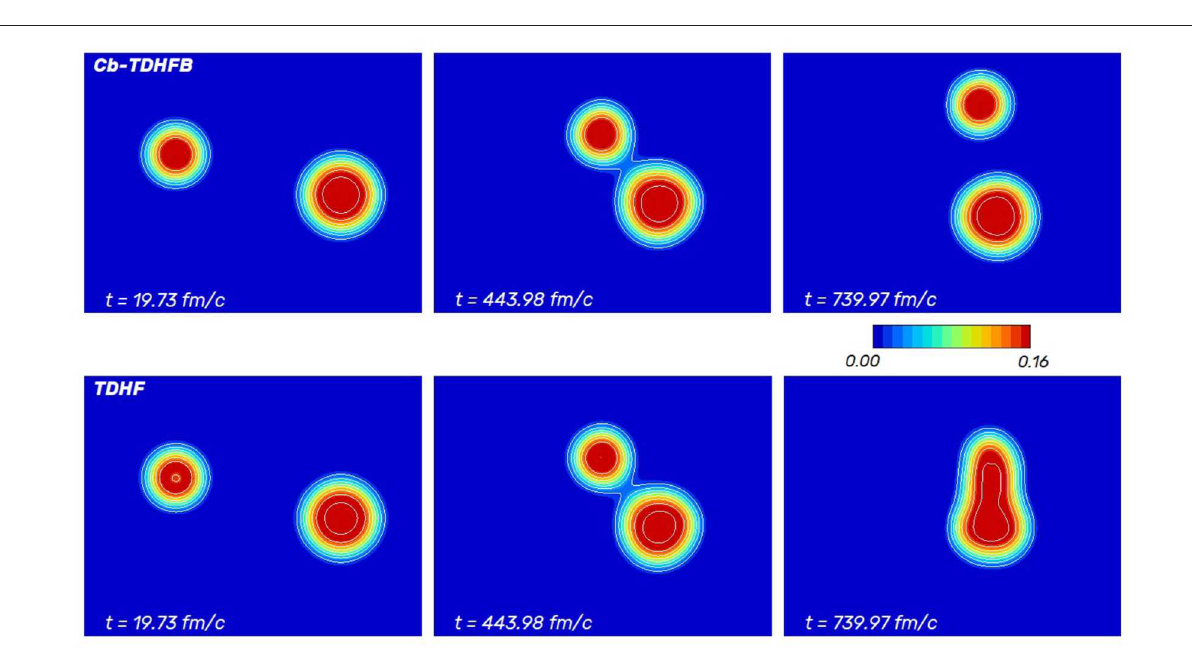
Frontiers in Physics |